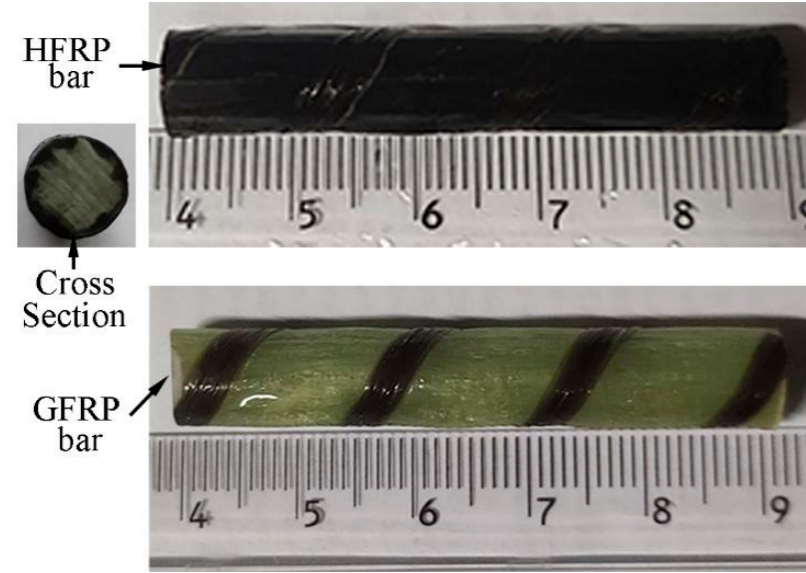
Figure 1. The image of GFRP and HFRP bars.